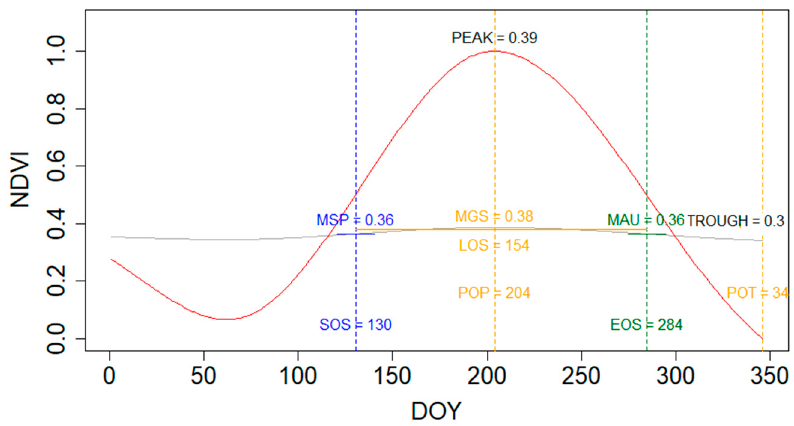
Figure 3. Average phenology metrics representing SOS, LOS, and EOS over South Asia (DOY = Days of Year; MSP = Mean Spring Value; POP = Position of the Peak; MAU = Mean Autumn Value; POT = Position of the Trough).